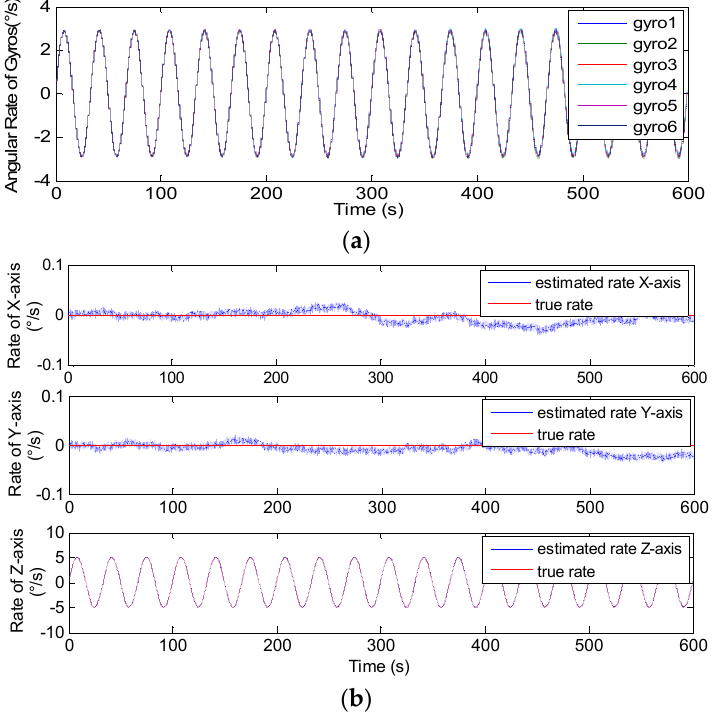
Figure 16. Sinusoidal results of the 6-gyro MIMU system for scheme 1. ( a ) The outputs of the gyros. ( b ) The estimated results of the MIMU.